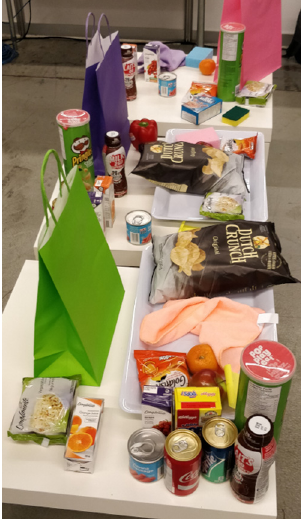
Figure 3: Objects typically manipulated by the robot.